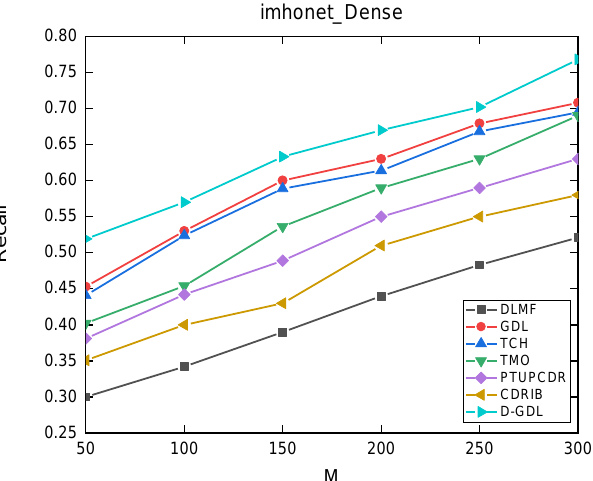
Figure A12. Performance of D-GDL against the comparative approaches based on Recall vs. M for Imhonet dataset in the sparse setting.